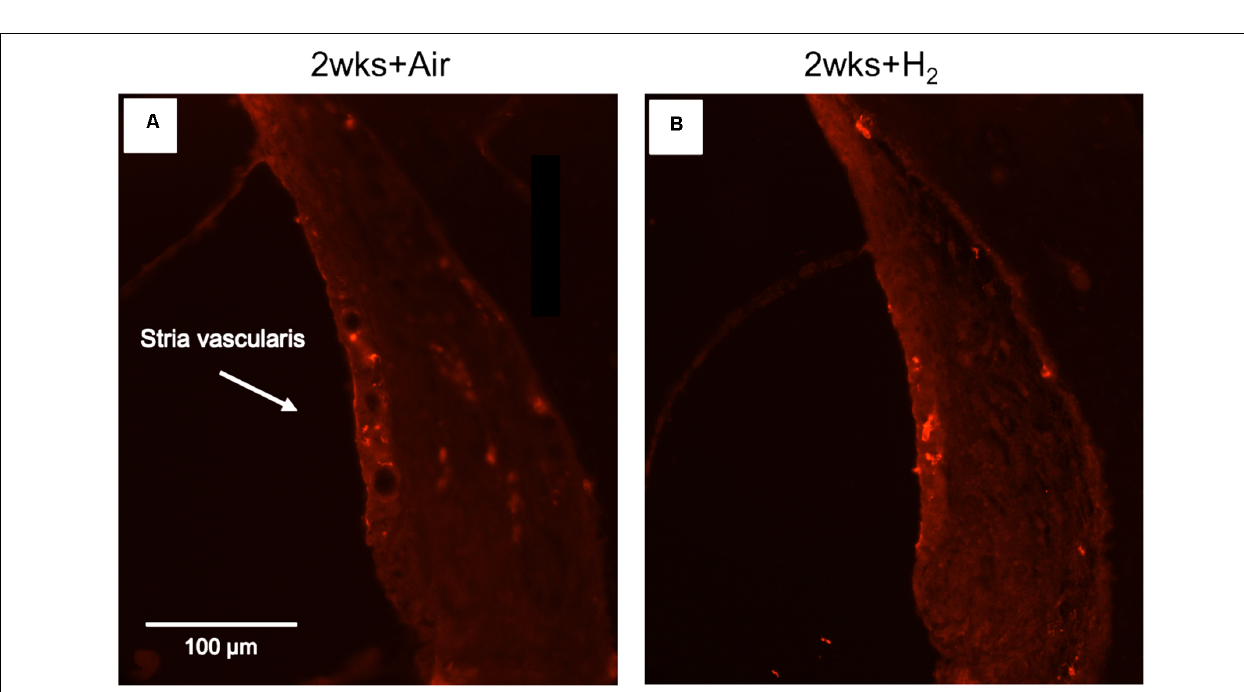
FIGURE 6 | Quantification of the immunoreactivity of synaptophysin in the synapse area of (A) IHCs and (B) OHCs of animals not exposed (normal) and exposed to noise followed by inhalation of H 2 (Noise + H 2 ) and air (Noise + Air). The immunoreactivity was measured at two points on the basilar membrane, 7 and 12 mm from the round window. Data are presented as mean + SEM. * p < 0.05, ** p < 0.01 and *** p < 0.001.